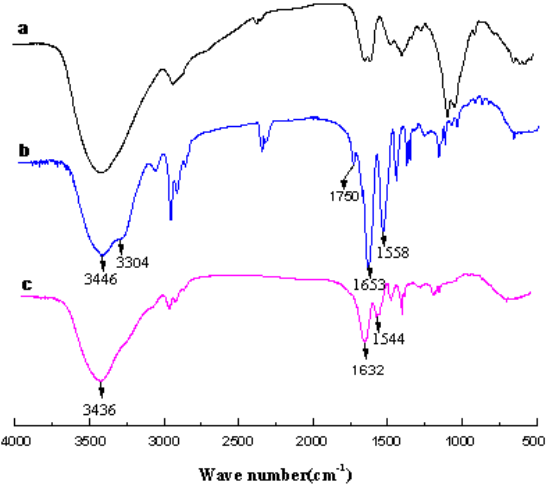
Figure 4. FT-IR spectra of ( a ) GA; ( b ) GA-PNIPAM (ii); ( c ) GA-PNIPAM (i).